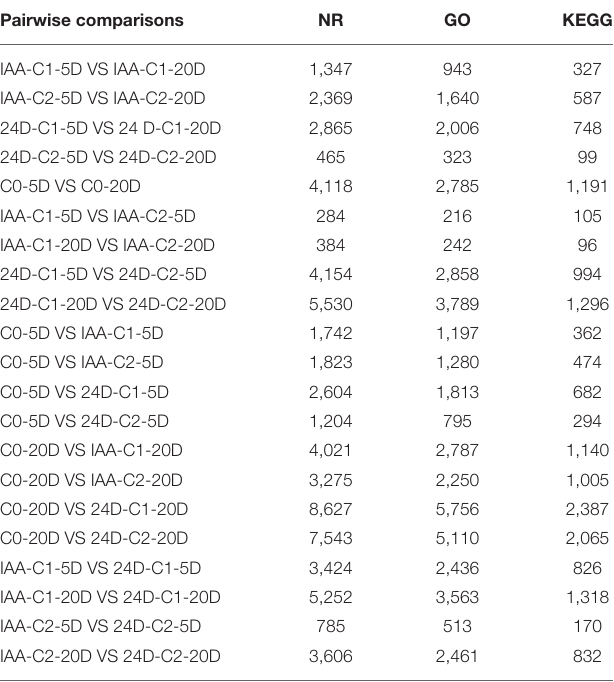
TABLE 2 | Summary of annotated genes in each database of the pairwise comparisons. Pairwise comparisons NR